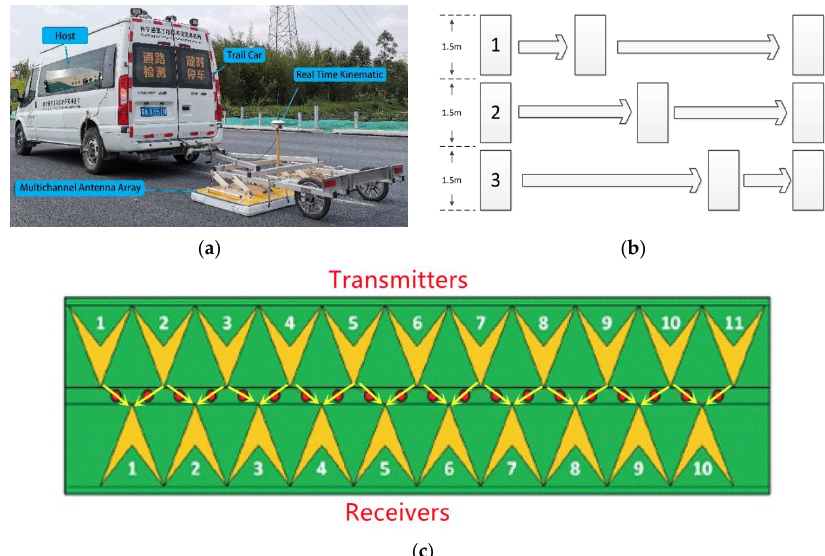
Figure 1. Onboard three-dimensional ground penetrating radar system and detection principle. ( a ) Onboard three-dimensional ground penetrating radar system. ( b ) Schematic diagram of 3D ground penetrating radar site detection (1.5 m means the width of detect line, numbers (1–3) mean the serial number of detect line). ( c ) Antenna combination configuration diagram (Numbers (1–11) mean the serial number of transmitters or receivers and yellow arrows mean the direction of electromagnetic wave propagation).